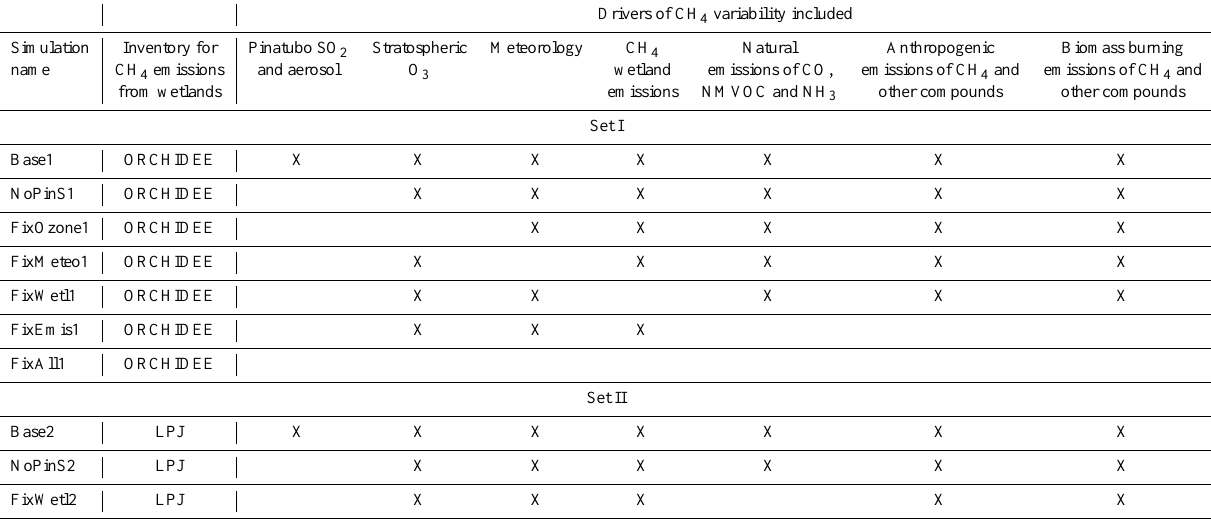
Table 2. Set-up of the simulations, including the CH 4 wetland inventory used and the drivers of CH 4 included in each simulation. The crosses indicate that the variability of a certain driver is included in the simulation. Otherwise the driver is not included (in the case of Pinatubo SO 2 and aerosol) or 1990 values are used throughout the